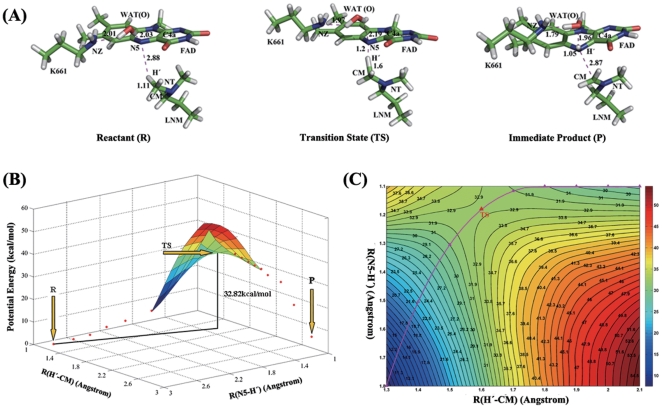
The potential energy surface of the reductive half-reaction in the demethylation of LSD1-CoREST-substrate complex.(A) The QM/MM optimized structures of the reactant (R), transition state (TS), and immediate product (P). For clarity, only the structures in the QM region have been shown. (B) The potential energy surface (PES) of the reductive half-reaction along the defined reaction coordinates. (C) Contour plot of the PES corresponding to the central part in (B). The pink triangle line represents the lowest energy pathway on the calculated PES and the position of the TS is marked by a red triangle.